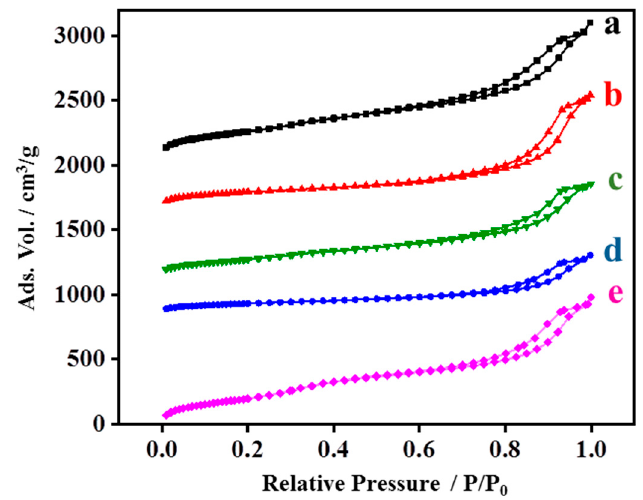
Figure 5. N 2 adsorption–desorption isotherms of the Pd NPs-UVM-7 / PDA- n catalysts. ( a ) n = 1 , ( b ) n = 2 , ( c ) n = 3 , ( d ) n = 4 , and ( e ) n = 5 . (curves has been y-shifted for clarity: (a) 2080, (b) 1660, (c) 1130, and (d) 830 cm 3 / g). Table 2. Textural parameters of the pure UVM-7 silica and the Pd NPs-UVM-7 / PDA-n catalysts Catalyst.